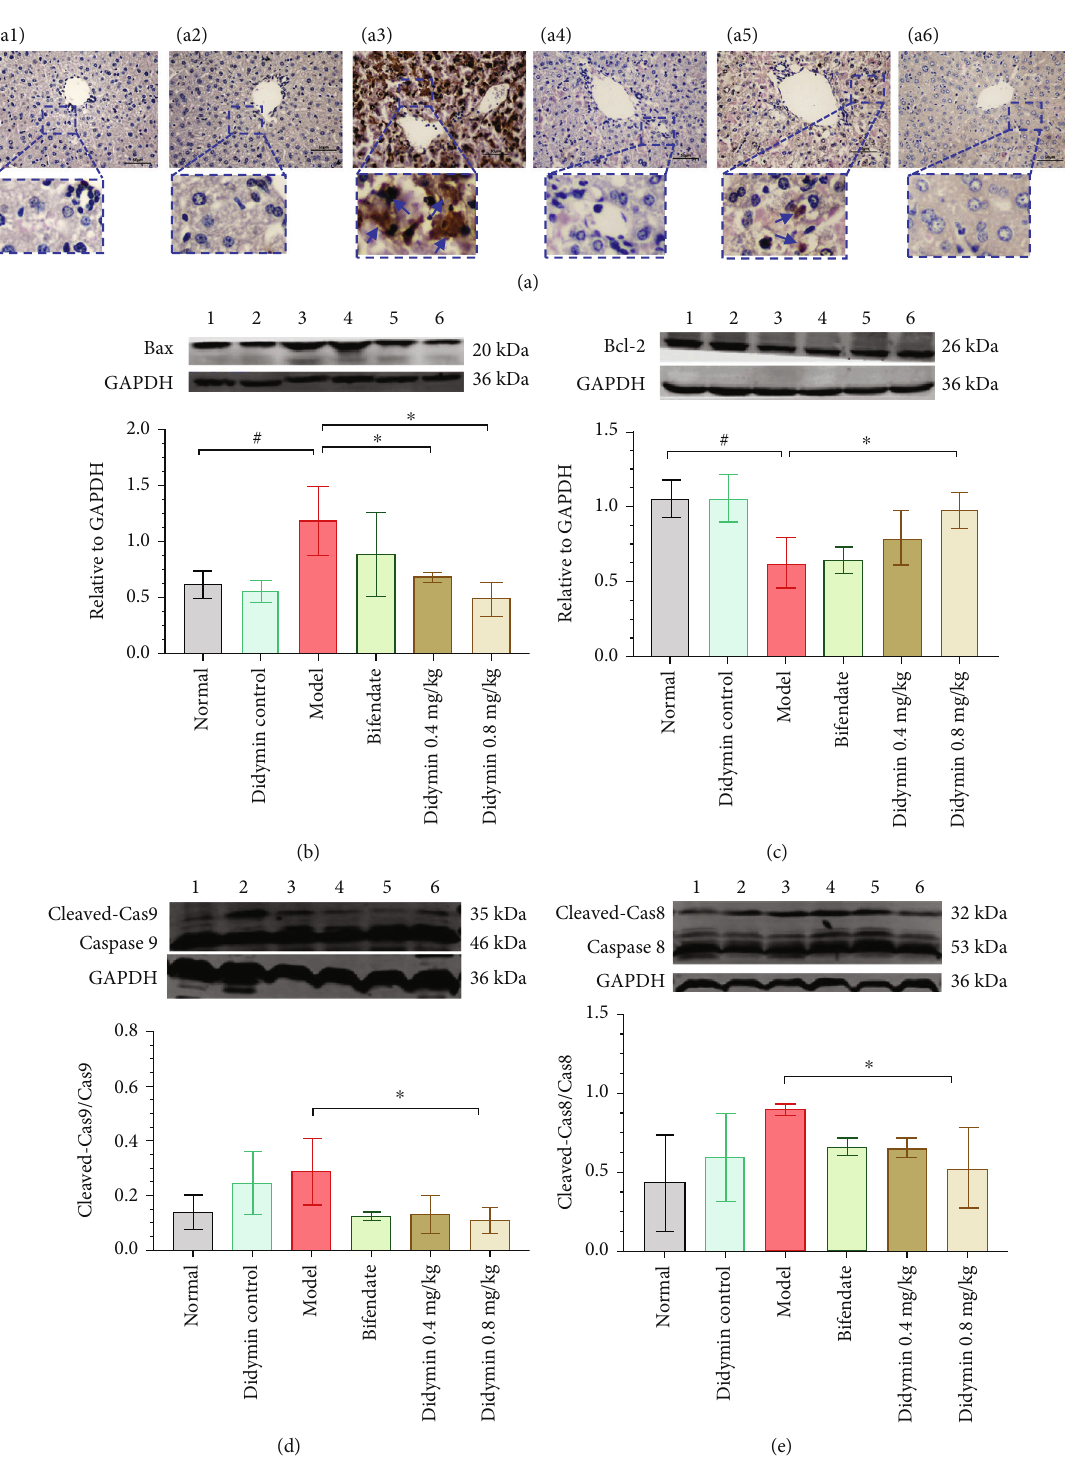
Figure 4: Didymin ameliorated hepatocytes apoptosis in LPS/D-Gal-induced ALI. (a) The hepatic apoptosis was detected by TUNEL staining (400x); the arrow meant hepatocyte apoptosis. (b – e) The expressions of Bcl-2 family proteins and Cleaved-caspase-9 and -8 were determined by western blot. Bands 1 to 6, respectively, represent the normal control group, didymin control group, model group, bifendate-treated group, and low- and high-dosages of didymin-treated groups. The data are presented as mean ± SD . # P < 0 : 05 vs. the normal group; ∗ P < 0 : 05 vs. the model